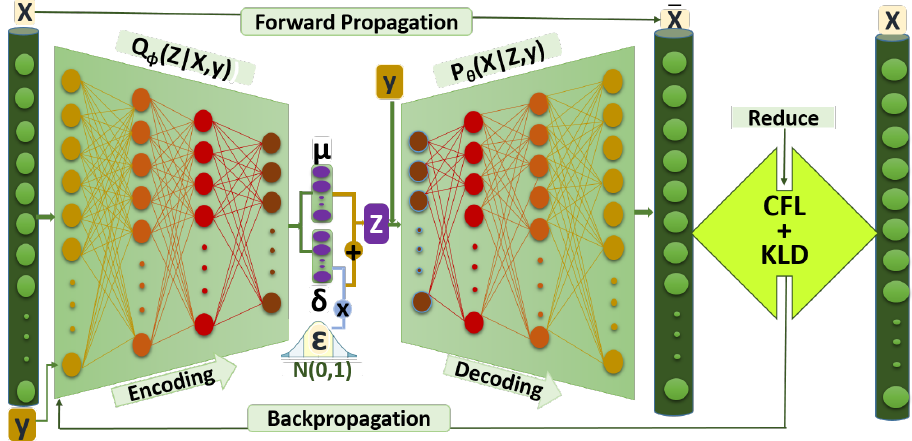
Figure 2. Class-wise Focal Loss Variational AutoEncoder